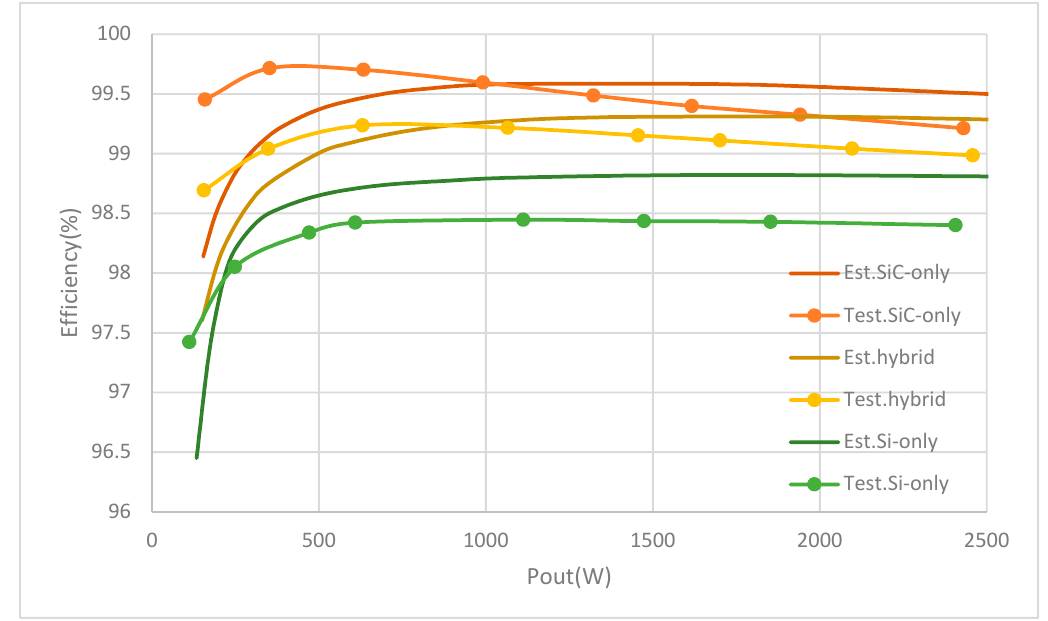
Figure 12. Comparison of prediction and experimental efficiency curves.